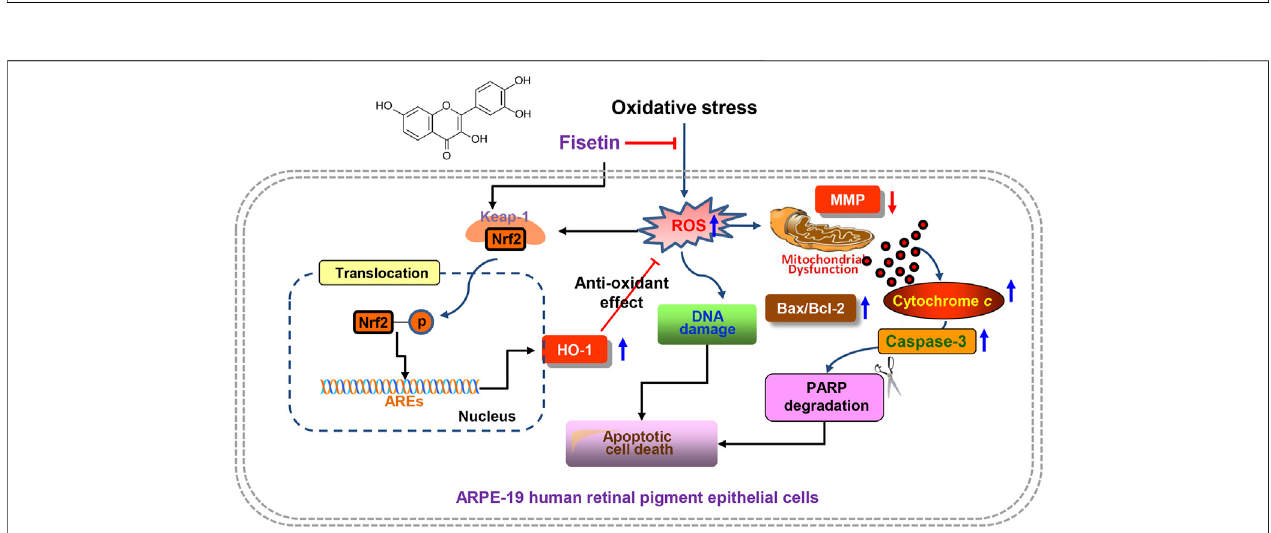
FIGURE 8| Graphical description of fi setin suppressing H 2 O 2 -induced oxidative damage in human RPE ARPE-19 cells through Nrf2-mediated HO-1 activation. In brief, fi setin signi fi cantly enhanced the expression of HO-1 along with activation of Nrf2 and reduced DNA damage, mitochondrial dysfunction and apoptosis in H 2 O 2 - treatedARPE-19cells.However,thesebene fi cialeffectswereabolishedinthepresenceofaninhibitor ofHO-1activity, indicatingthattheenhanced expressionofHO-1 contributed to the mitigating effect of fi setin on oxidative stress-induced cellular injury. Taking together, these results provide strong evidence that fi setin as a ROS scavenger can rescue RPE cells from oxidative damage through activation of the Nrf2/HO-1 axis.